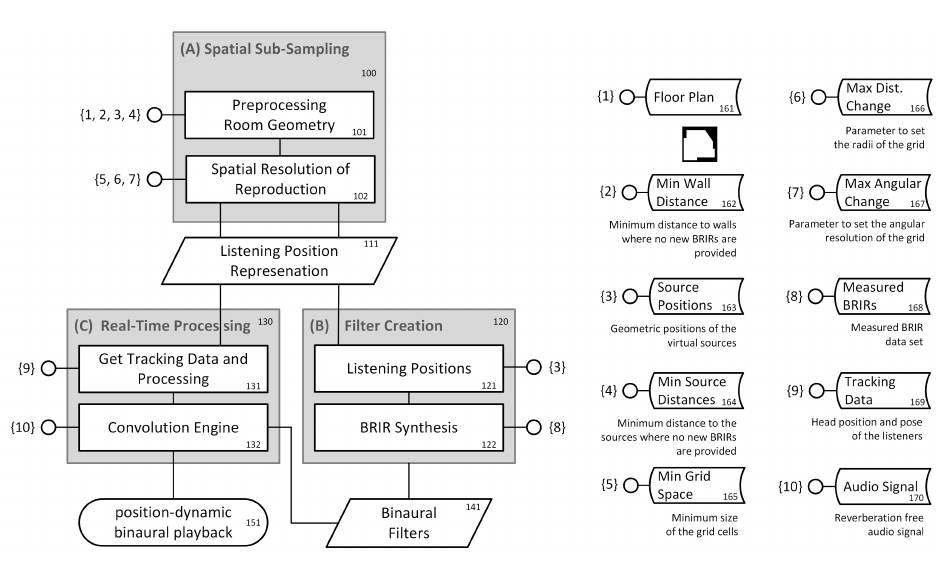
Figure 2. Block diagram of a specific position-dynamic binaural synthesis system including the provision of BRIRs in the room (100), filter creation (120), and real-time processing (130). The separated blocks on the right indicate input data to blocks on the left side. The descriptions in the text refer to the several blocks indicated by the number of each